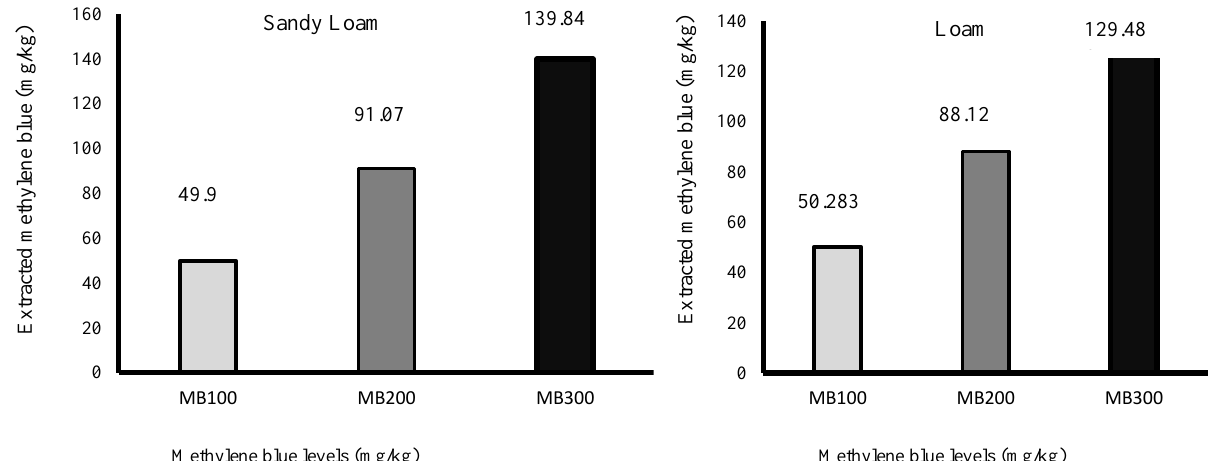
Fig. 2. Effects of various MB concentrations on extracted MB from SL and L soils (each column with average of 42 samples; different letters indicate significant differences in the mean of different treatments;